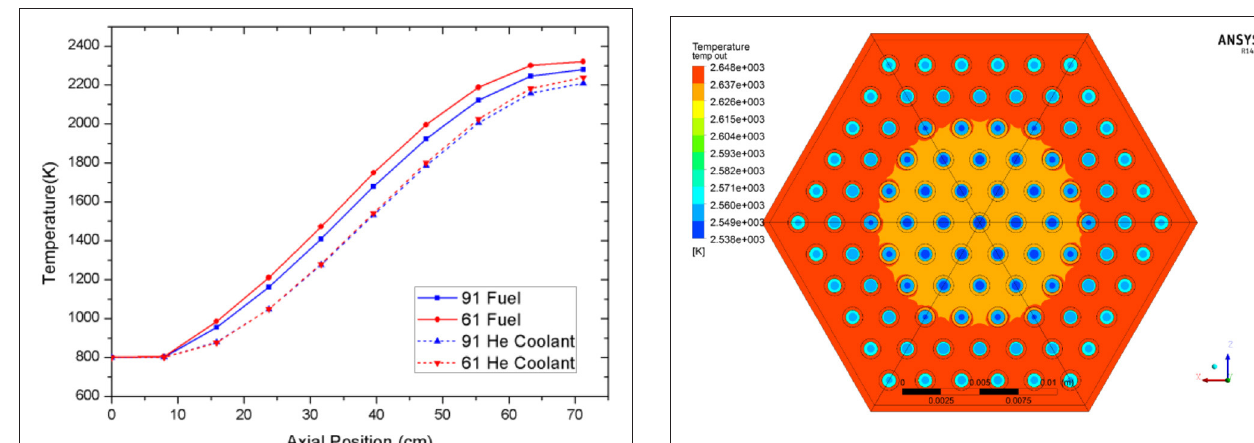
FIGURE 13 | Radial temperature distribution of hot channel in 91 coolant channel case.